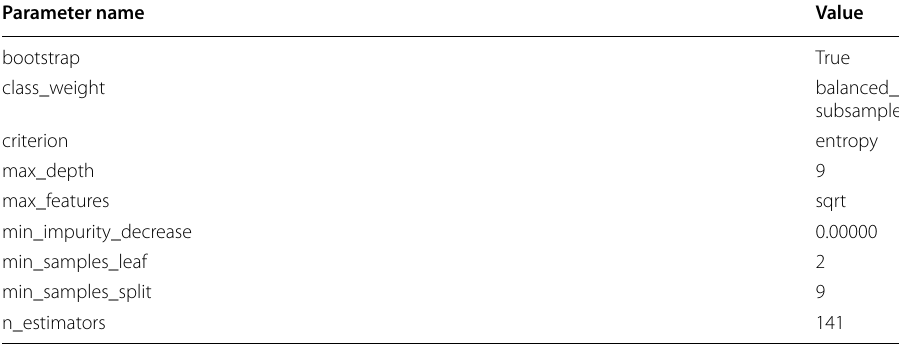
Parameter values for classifier yielding best results in terms of AUC